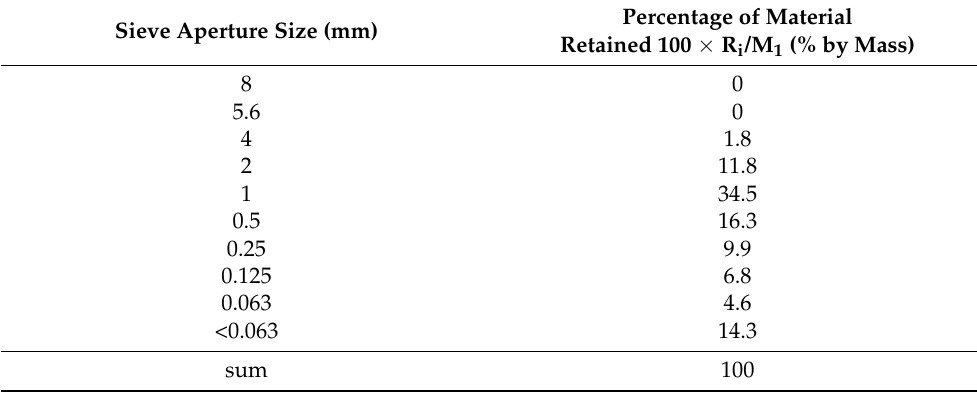
Figure 7. Particle size distribution of the virgin aggregate (VA) used in the mixture. Table 9. Grading of virgin aggregate (VA) used in the mixture.